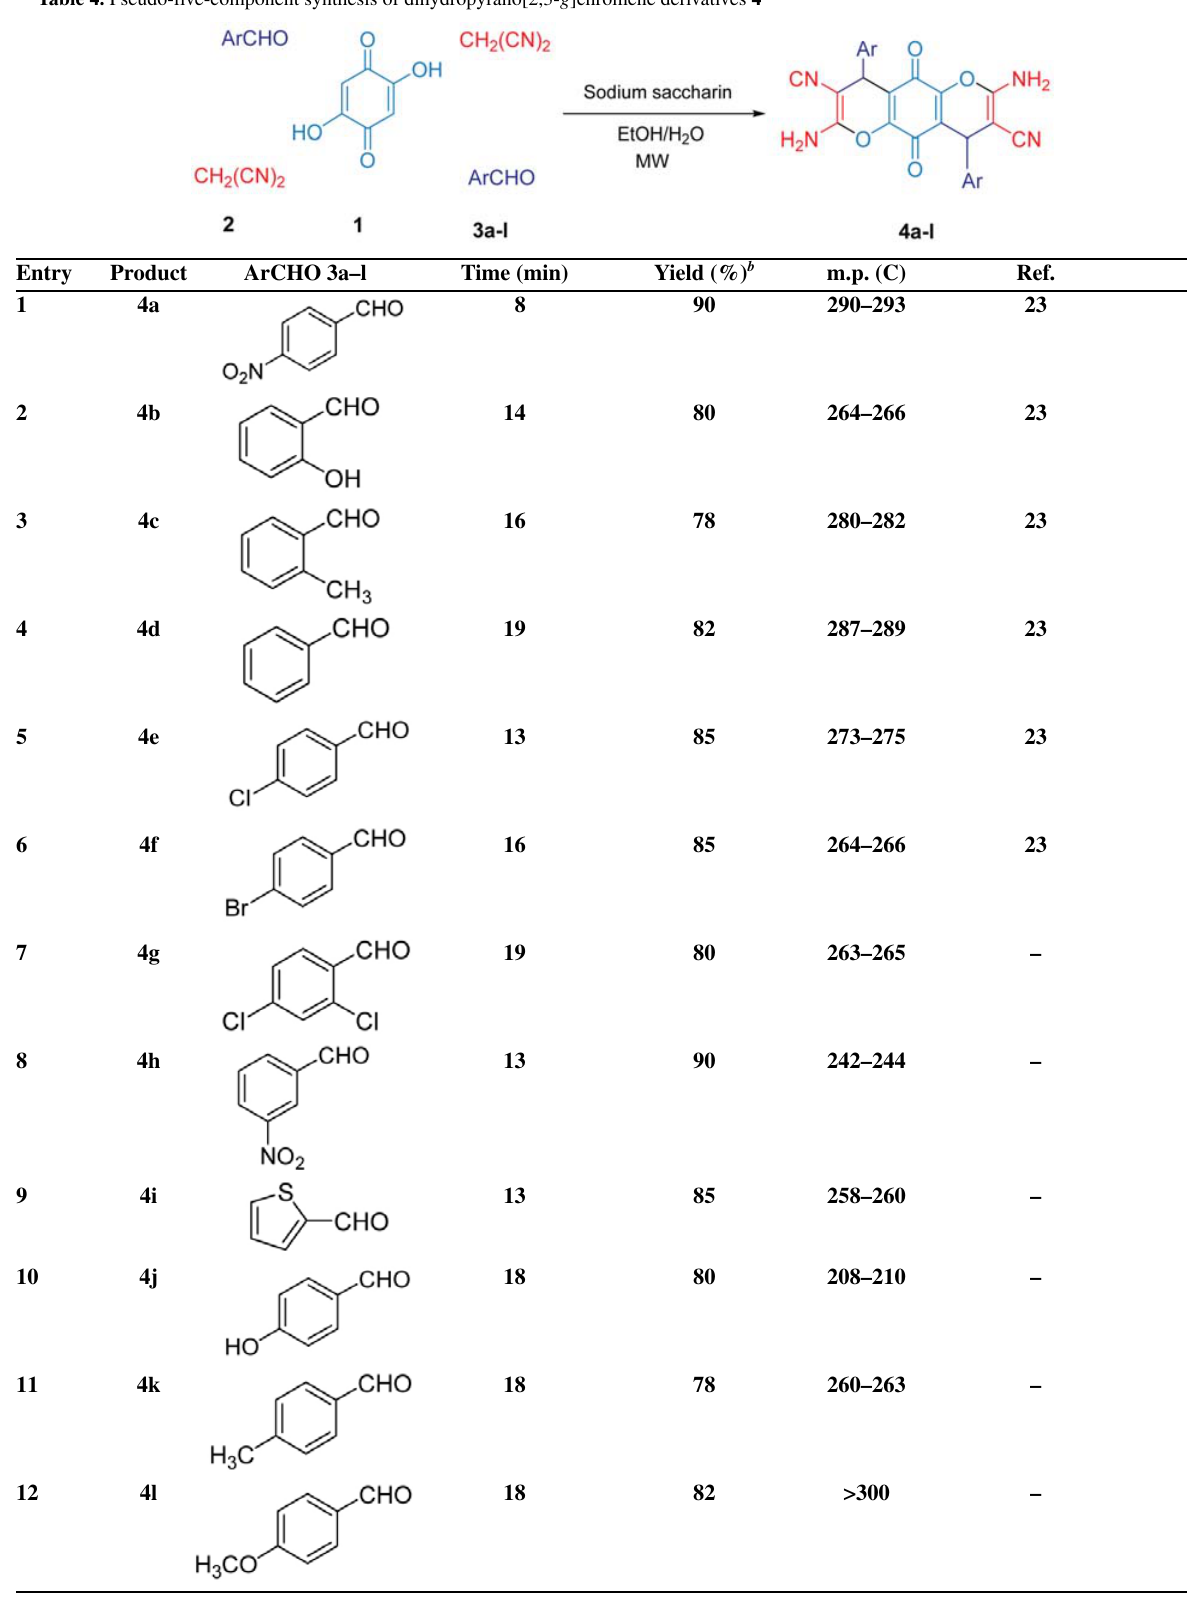
Table 4. Pseudo-five-component synthesis of dihydropyrano [ 2,3- g ] chromene derivatives 4